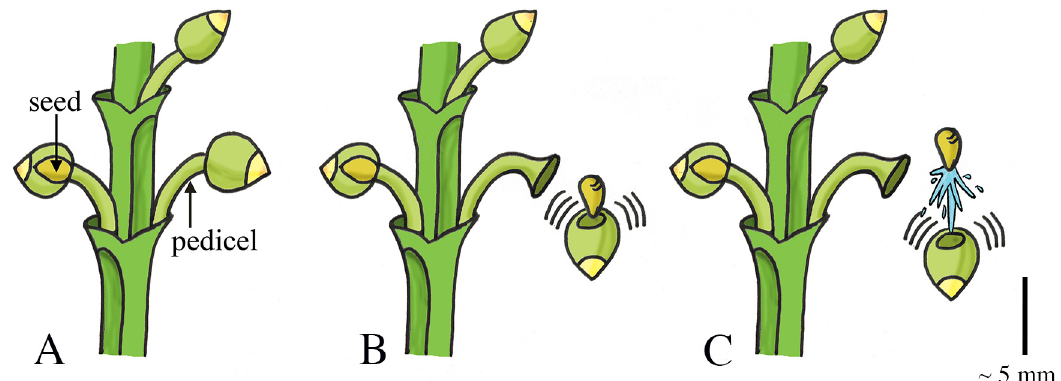
Fig 10. Fluid pressure catapult mechanism in Arceuthobium . (A) The ripe fruits of Arceuthobium that contains the fusiform-spheric seeds and are attached to short stems (pedicels). (B – C) When a critical pressure is reached, the fruit breaks free from the pedicel and discharges the seed together with the liquid cell content. Scale bar 5 mm. Drawings based on schematic drawings in [65].